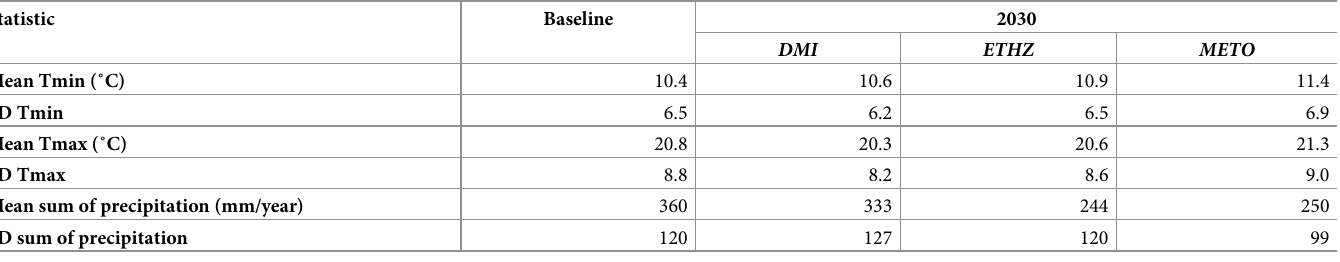
Table 1. Summarized mean and standard deviation (SD) baseline climate data and projected changes for 2030 for each of the three climate models for Ukraine � .